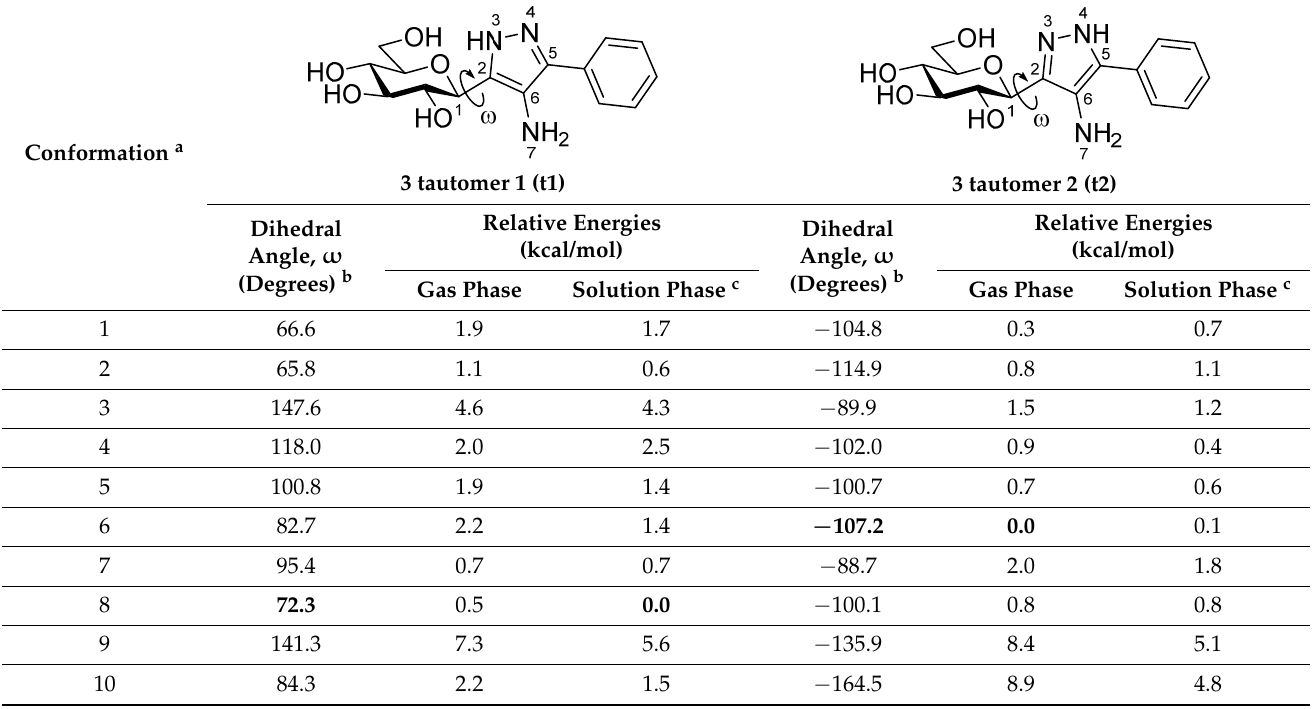
a Conformations were predicted using Monte Carlo prior to optimizations using DFT, as described in Table 3. Results of MM-GBSA post-docking calculations with the predicted binding tautomer/state highlighted in bold italics .